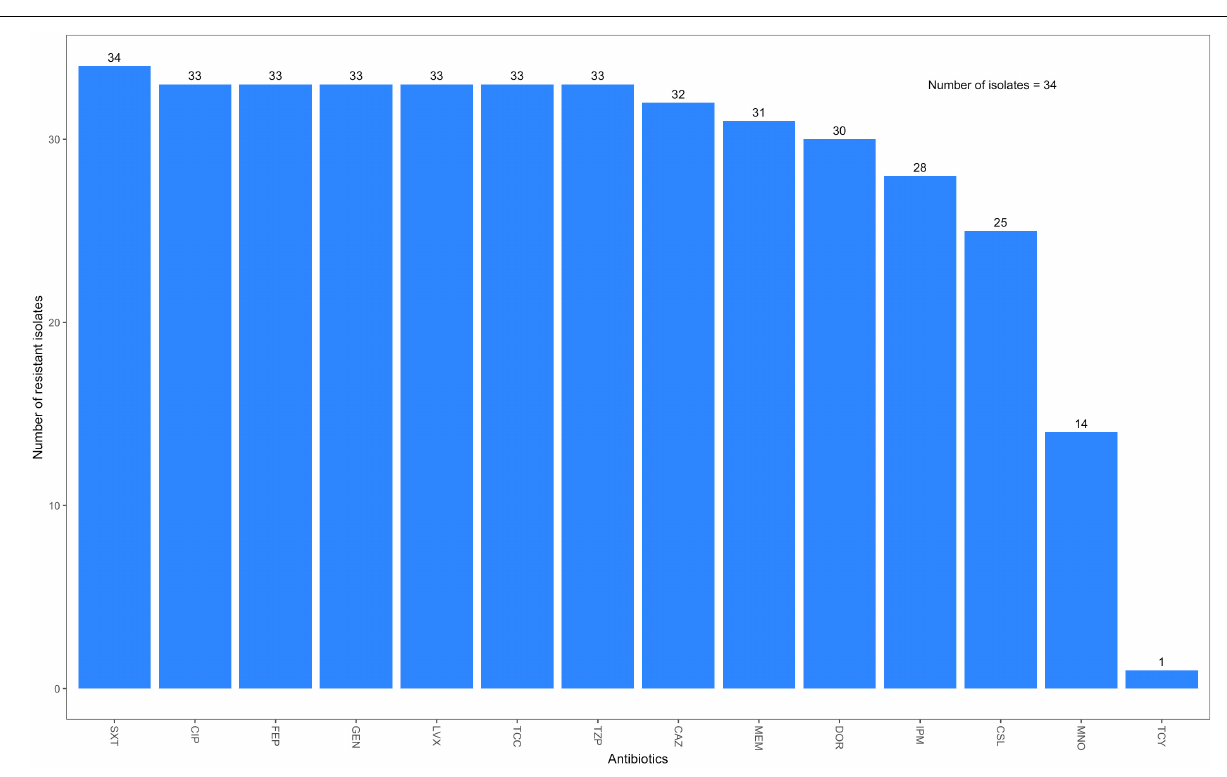
FIGURE 4 | Phenotypic resistance of A. baumannii isolates from OAUTCH, Ife, Osun State, and UCH, Ibadan, Oyo State, Nigeria, between 2017 and 2019. SXT, trimethoprim/sulfamethoxazole; CIP, ciprofloxacin; FEP, cefepime; GEN, gentamicin; LVX, levofloxacin; TCC, ticarcillin/clavulanic acid; TZP, piperacillin/tazobactam; CAZ, ceftazidime; MEM, meropenem; DOR, doripenem; IPM, imipenem; CSL, cefoperazone/sulbactam; MNO, minocycline; TCY,